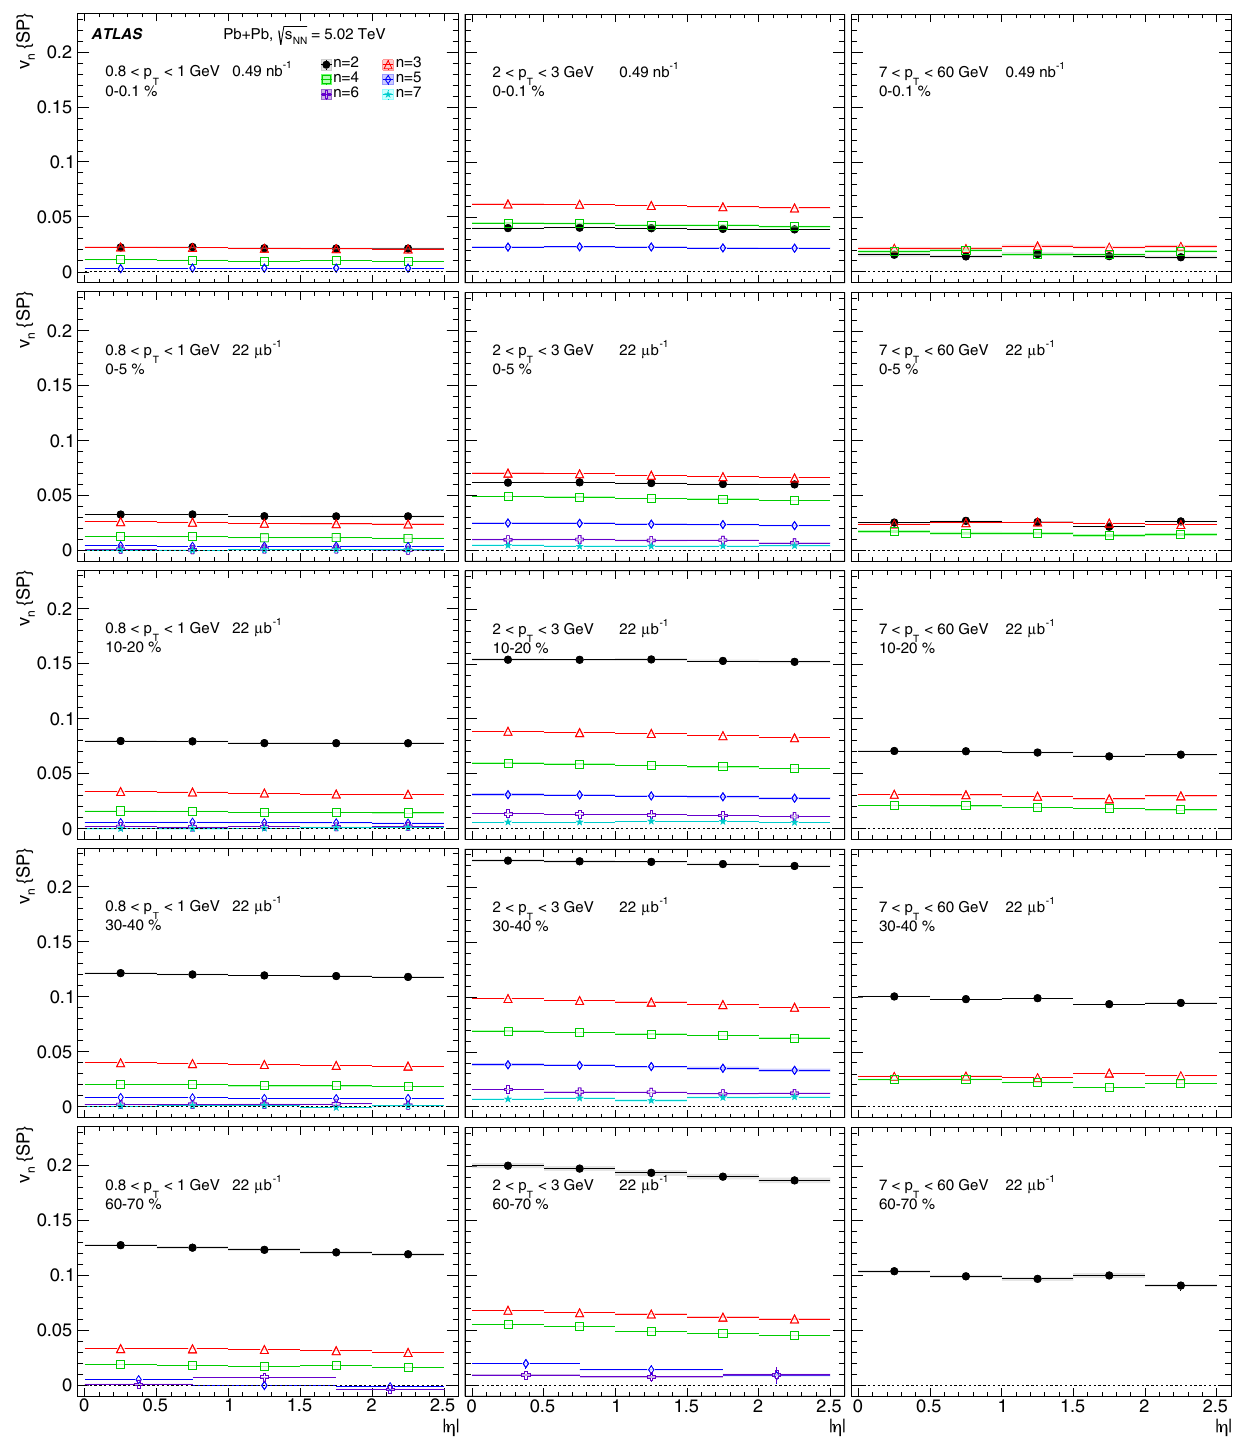
Fig. 11 The v n as a function of pseudorapidity obtained with the SP method, for transverse momentum ranges: 0 . 8 < p T < 1 GeV (left column), 2 < p T < 3 GeV (middle column) and 7 < p T < 60 GeV (right column) and for centrality intervals: 0–0.1% (top row),